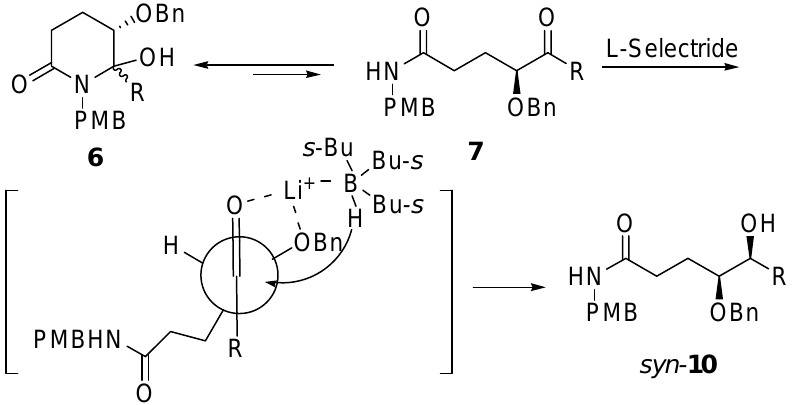
Figure 2. A plausible Cram chelation-controlled pathway for the syn -diastereoselective formation of syn- 10